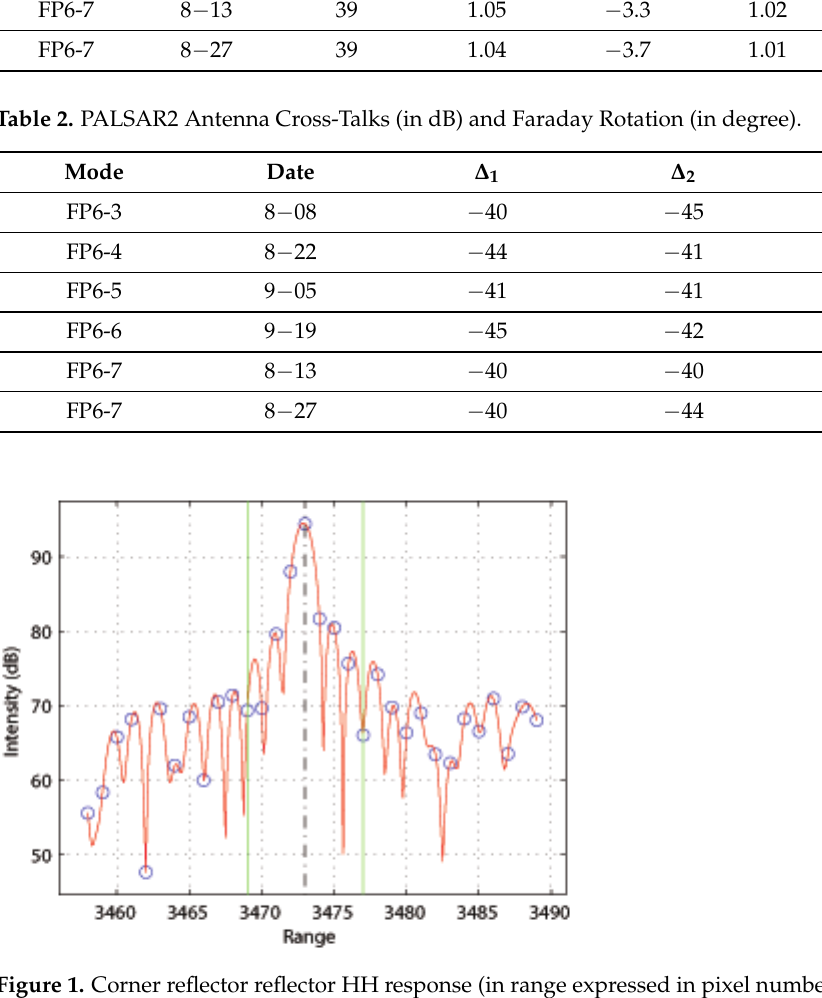
Figure 1. Corner reflector reflector HH response (in range expressed in pixel